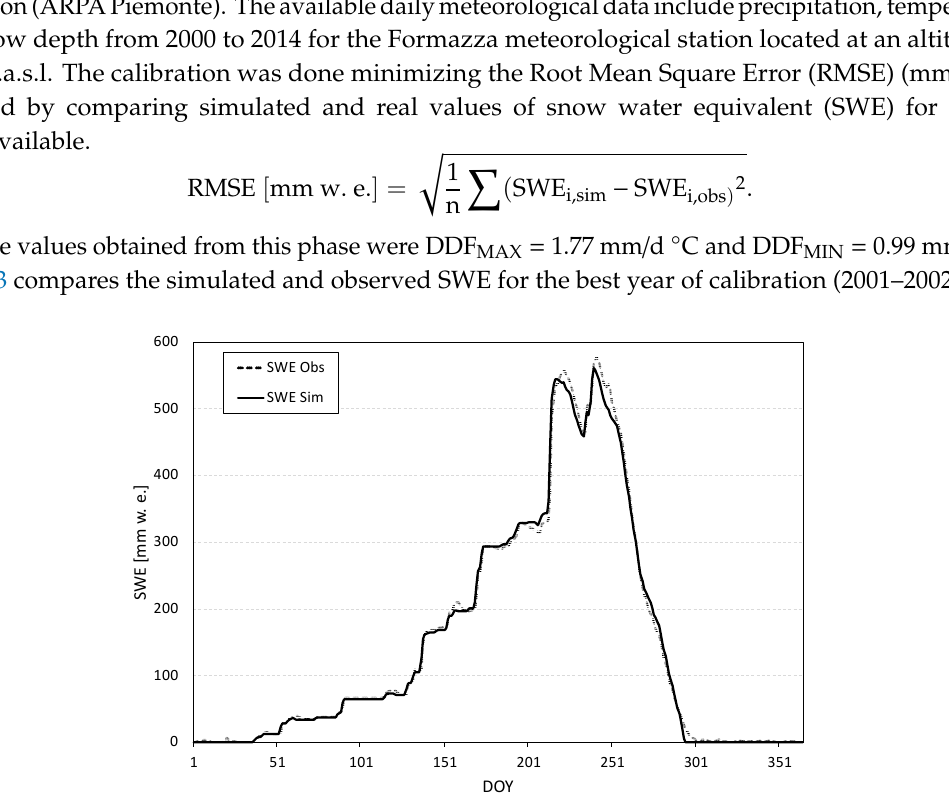
Figure 3. Comparison between snow water equivalent (SWE) simulated and observed for the best year of simulation. Please note that the series is considered in hydrological years (1 October 2001–3 September 2002).